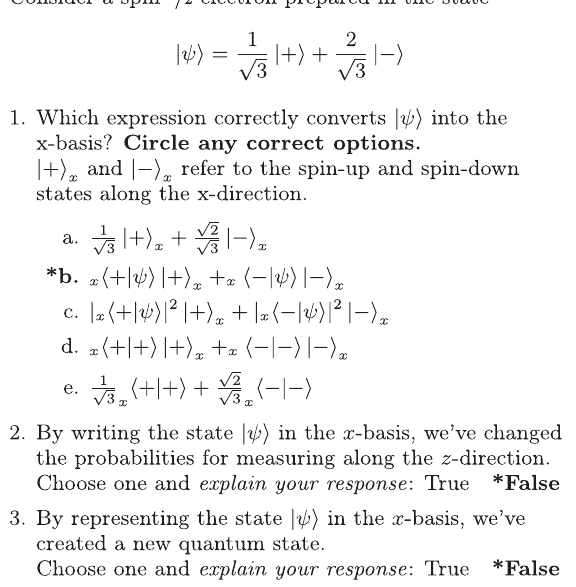
FIG. 5. Survey 1: Three of the questions given to students as a pre-test for the quantum basis tutorial. Questions are numbered here for reference. Correct answers are bolded and starred. In year 3, question 2 was used again on the quiz, and question 3 was incorporated into survey